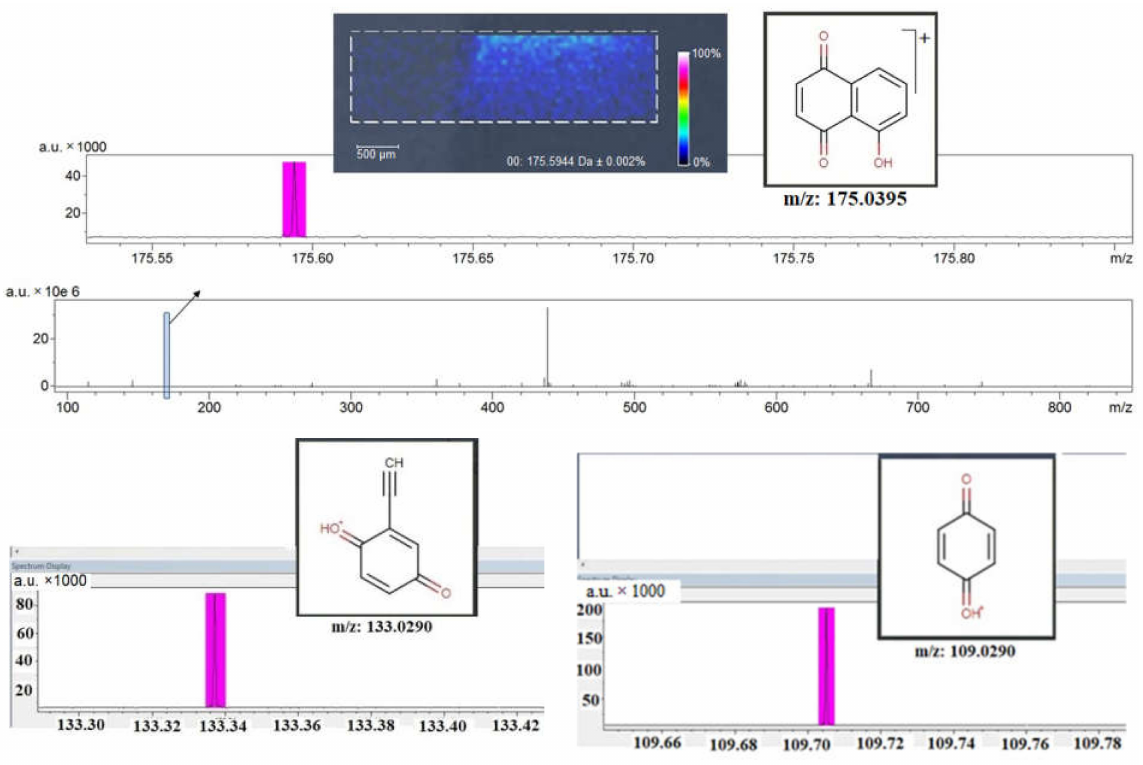
Figure 5. MALDI analysis of GOJu